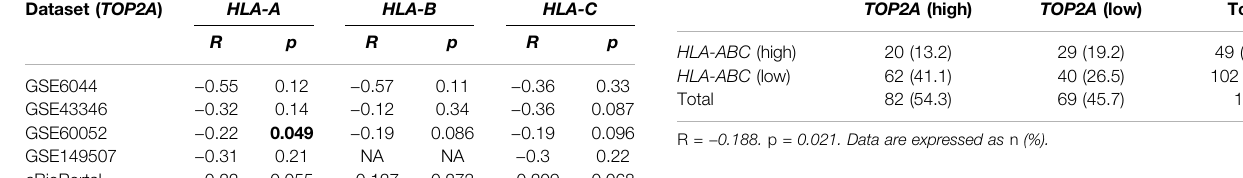
TABLE 2 | Correlation between TOP2A expression and HLA-ABC expression in four GSE datasets and the cBioPortal website. Dataset ( TOP2A )